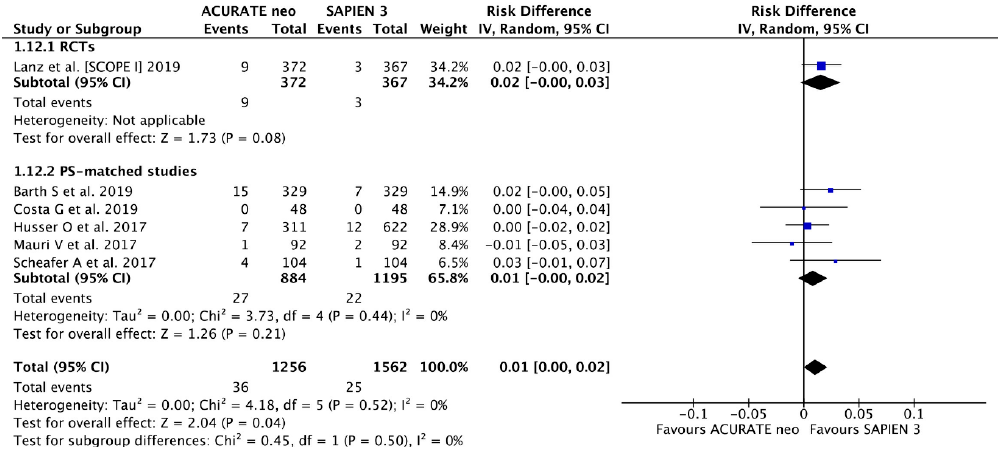
Figure A12. Clinical outcomes. Individual and summary risk ratios with corresponding 95% confidence intervals for the comparison of ACURATE neo and SAPIEN 3 in the analysis of 30-day all-cause mortality taking into account “0 events”.